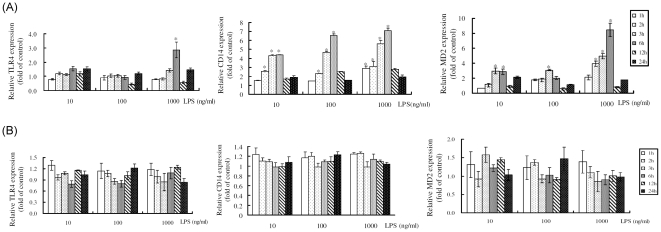
Kinetic changes in TLR4, CD14, and MD2 mRNA expression detected by qRT- PCR after LPS treatment.Total RNA isolated from (A) C9 rat hepatocytes and (B) HSC-T6 cells at 1, 2, 3, 6, 12, and 24 h after 10–1,000 ng/mL LPS treatment. TLR4, CD14, and MD2 mRNA expression was normalized using the mRNA of housekeeping gene GAPDH. The expression of TLR4, CD14, and MD2 mRNA expression is shown relative to that of the time-matched control cells (without LPS treatment). Data are expressed as mean±SE of three separate experiments.* indicates P<0.05 relative to time-matched control cells.